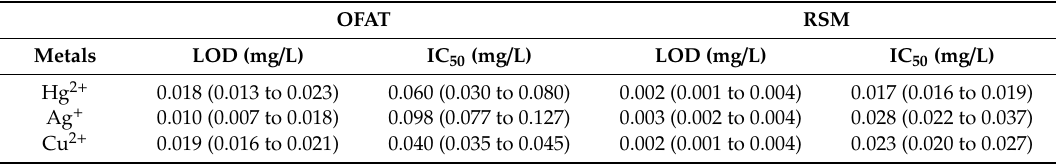
Figure 11. Ficin dye-binding assay of copper using RSM ( ) and OFAT ( (cid:52) ). Dashed lines represent the 95% confidence band. Error bars represent mean ± standard deviation ( n = 3). Table 4. Comparison of Limits of Detection (LOD) and IC 50 values for toxic metals assayed using the ficin dye-binding assay obtained using RSM and OFAT. Values in parentheses indicate 95% confidence interval .